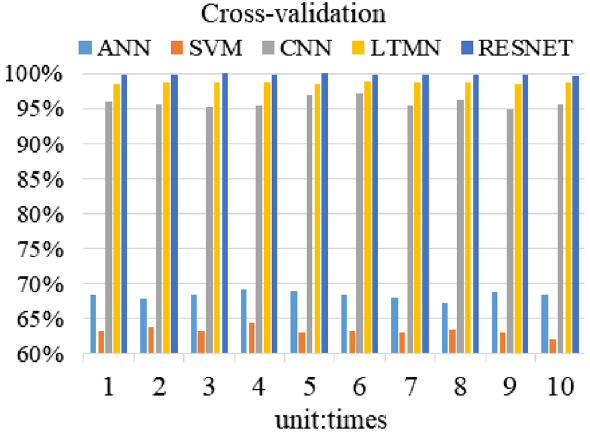
Figure 6. Cross validation